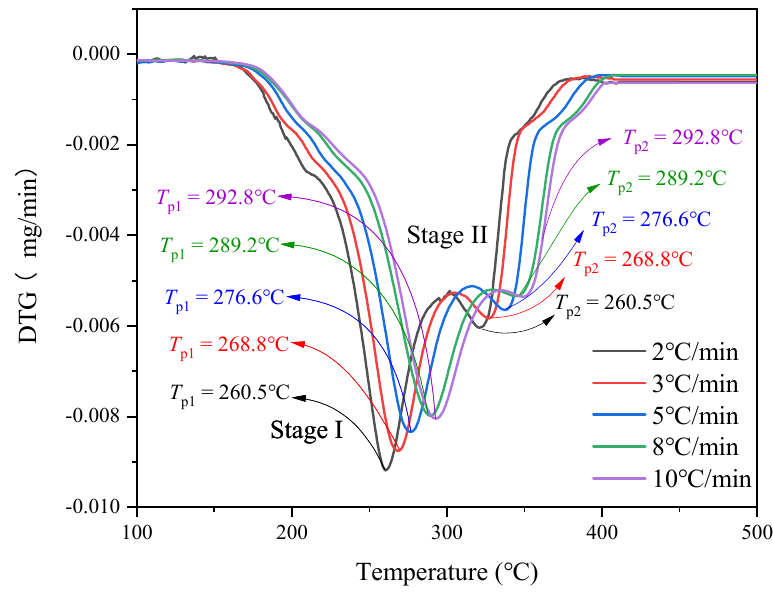
Figure 6. DTG curves of PSS + (NH 4 ) 2 SO 4 at five different β . Table 3. Characteristic temperature of PSS + (NH 4 ) 2 SO 4 in the DTG at different β . Stage